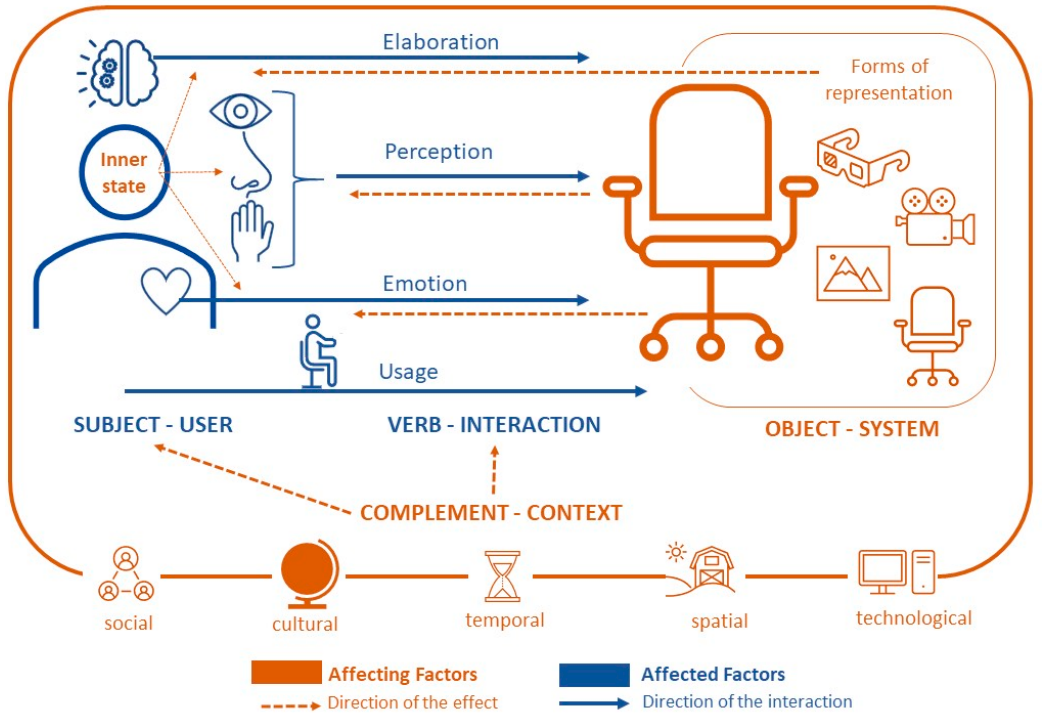
Figure 6. Graphical representation of the relationships between the main elements that characterize UX, shown in the semantic framework. Different colors represent the elements that affect (orange) or that are affected (blue).